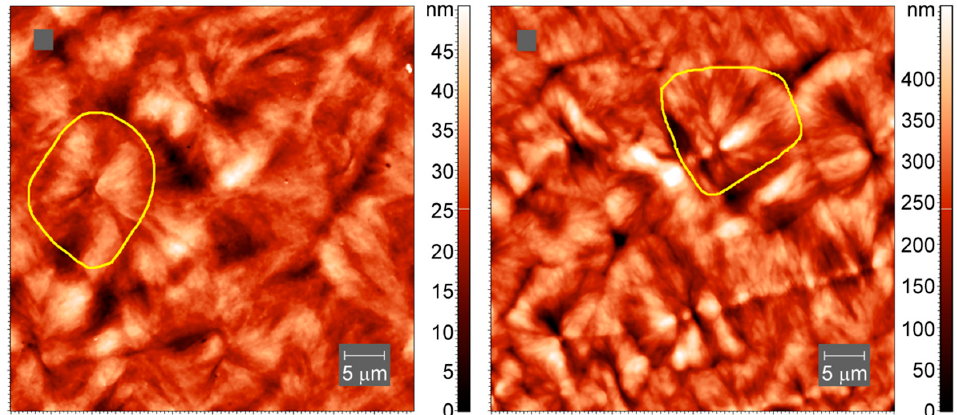
Figure 11. AFM tapping-mode images of spherulites in neat PCL ( left ) and cross-linked PCL with 5% BPO ( right ). Yellow lines outline one spherulite.